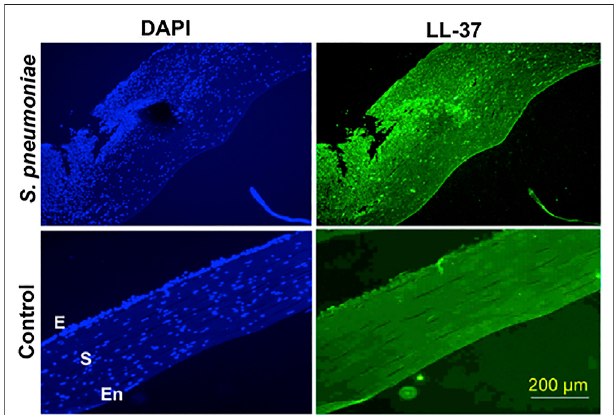
FIGURE 3 | LL-37 expression in corneal tissues obtained from S. pneumoniae keratitis patients. Corneal sections of keratitis patients obtained during corneal transplantation and control cadaveric corneas were stained withanti-LL-37antibody,followedbyAlexa fl uor488secondaryantibody andimagedundera fl uorescentmicroscopeusing10Xobjective.Thesections were counterstained with DAPI. E denotes epithelium, S-stroma, and En- endothelium. This fi gure is reprinted from reference Sharma et al.